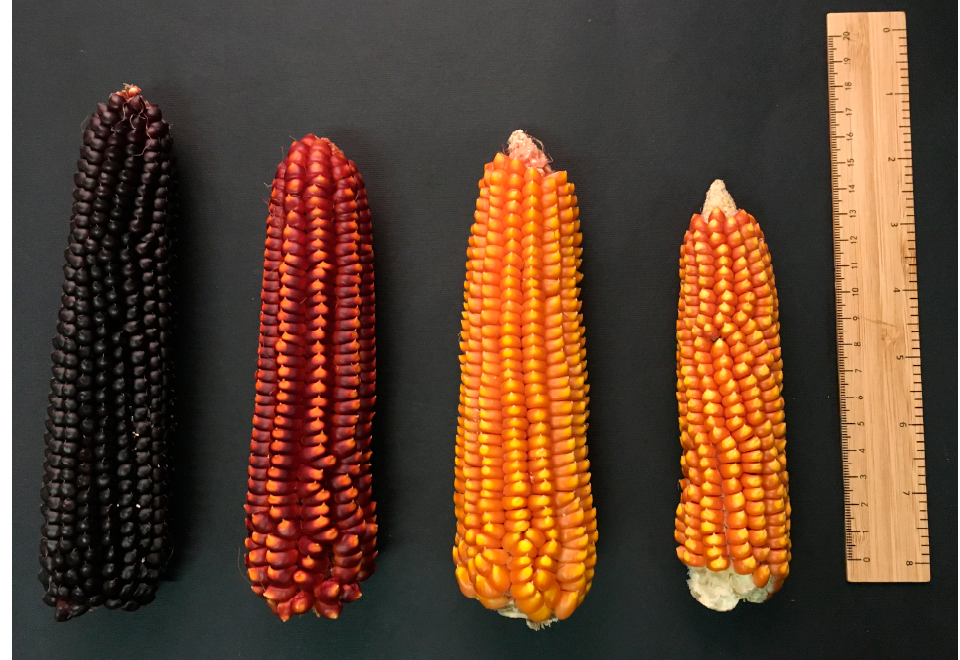
Figure 1. Four Italian maize landraces registered in the European Register of Conservation Varieties. From the left to the right: “Nero Spinoso”, “Rostrato Rosso di Rovetta”, “Scagliolo di Carenno” and “Spinato di Gandino”.